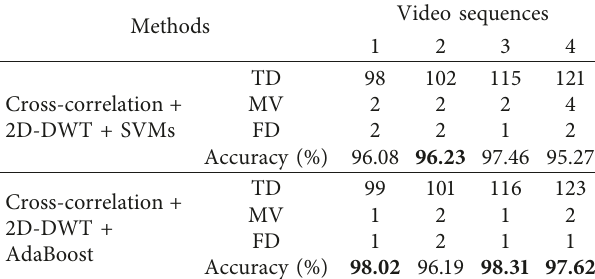
Table 1: Vehicle detection